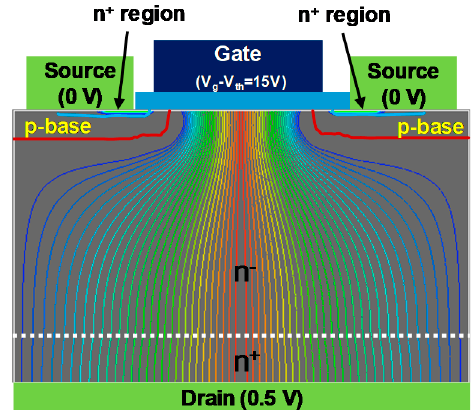
Figure 14. Simulated linear region electron current flow of the GaN DMOSFET with an L J of 3.0 μ m at V gs = 15 V and V ds = 0.5 V. In saturation regions, the electron current flows without tightening in an L J above 3 μ m.